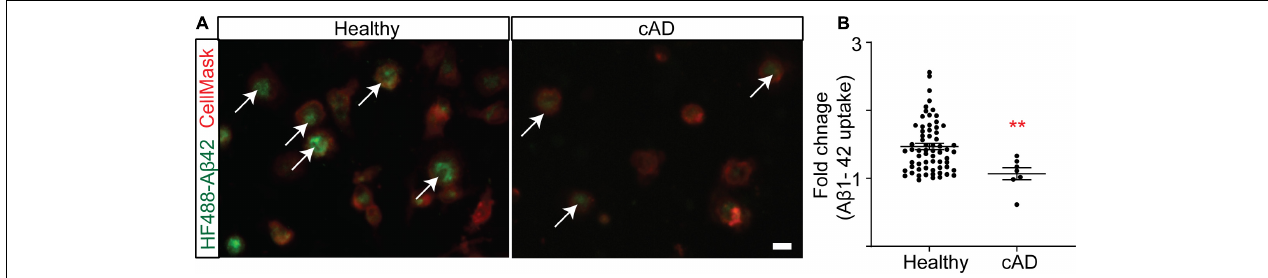
FIGURE 1 | Clinical AD (cAD) subjects are ineffective at phagocytosis compared to healthy subjects in RUSH Universities’ Memory and Aging Project (MAP) (Bennett et al., 2012; Bennett et al., 2018). Monocytes were seeded into a 384 well plate and differentiated to MDMi. (A) A representative image of MDMi incubated with HyLite Fluor-488 conjugated A β 1–42 for 2 h. CellMask was used to label the plasma membrane. Arrow indicates internalized A β in the healthy subjects. (B) Quantification of the mean fluorescence intensity of A β , represented as fold change. N = 65 for healthy groups and N = 7 for cAD group. Data were analyzed